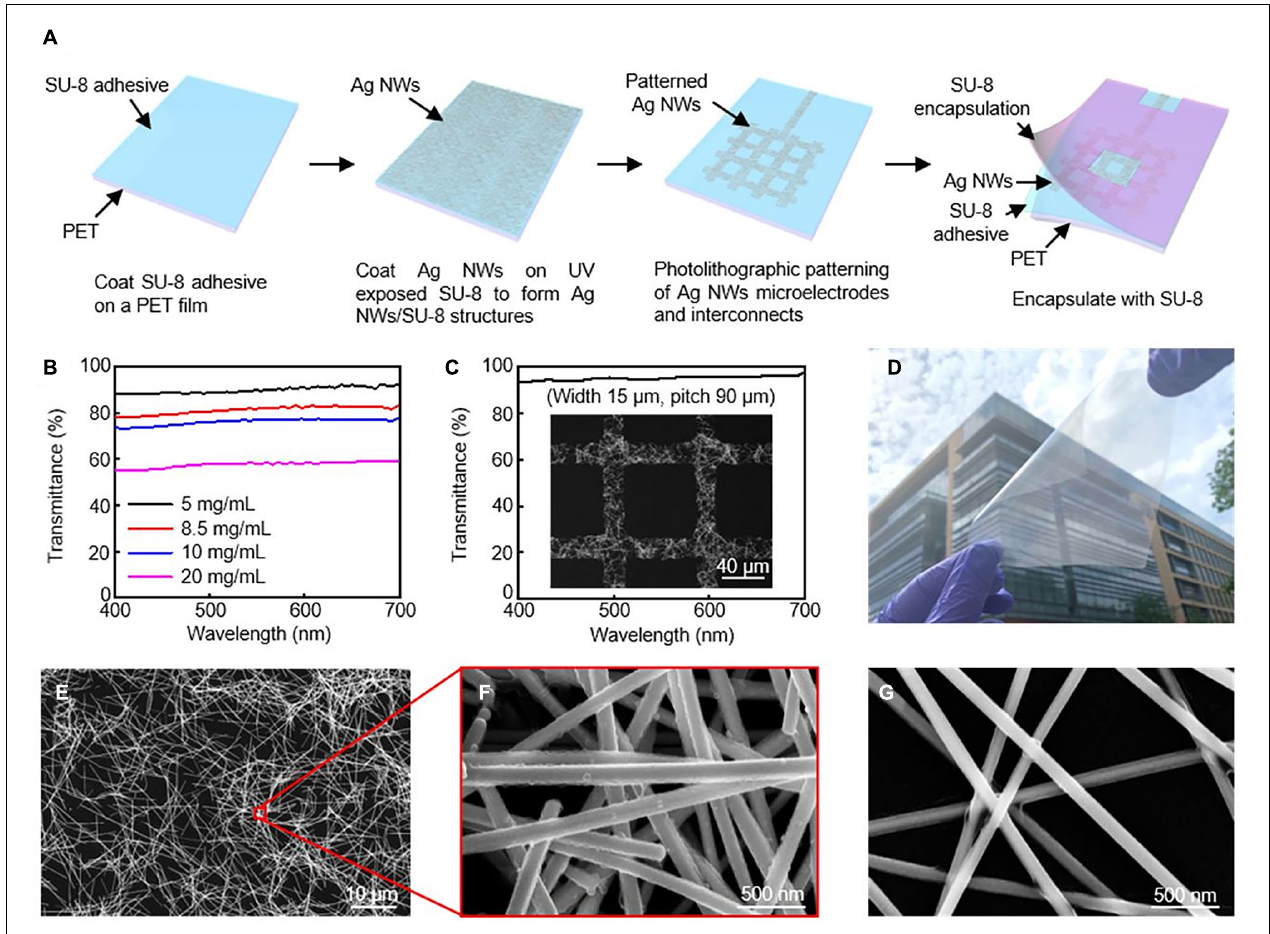
FIGURE 2 | Silver nanowires microelectrodes and interconnects. (A) Schematic illustration of fabrication procedure for AgNW microelectrodes and interconnects. (B) Transmission spectra for varying concentrations of AgNWs. (C) High transmittance AgNW grid from SEM image. (D) Optical image of 10 × 10 cm 2 Ag NW/SU-8/PET film. SEM images of AgNW at (E,F) 8.5 mg/mL, and (G) 5 mg/mL. Reproduced from Chen et al.